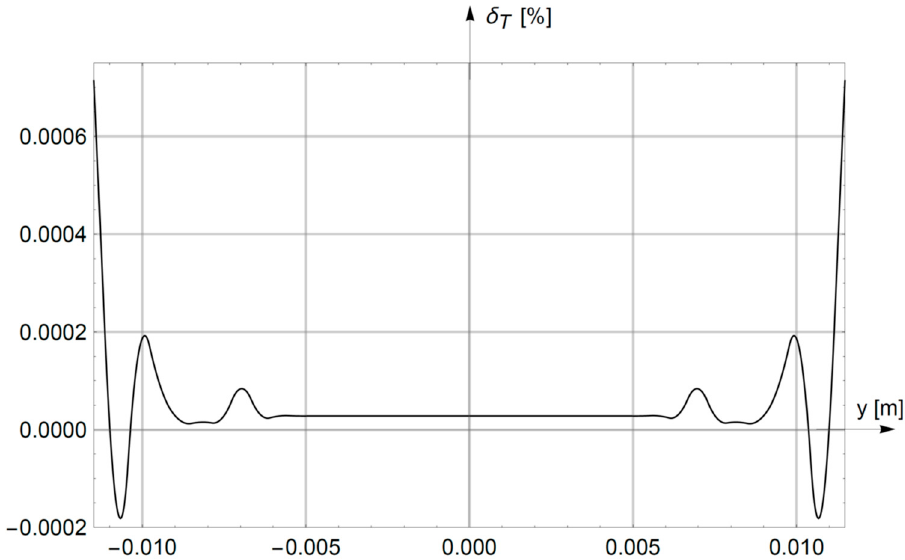
Figure 6. Relative differences (Equation (32)) between the results of the analytical–numerical method and the finite-element method for x = 0 (on the minor axis of the